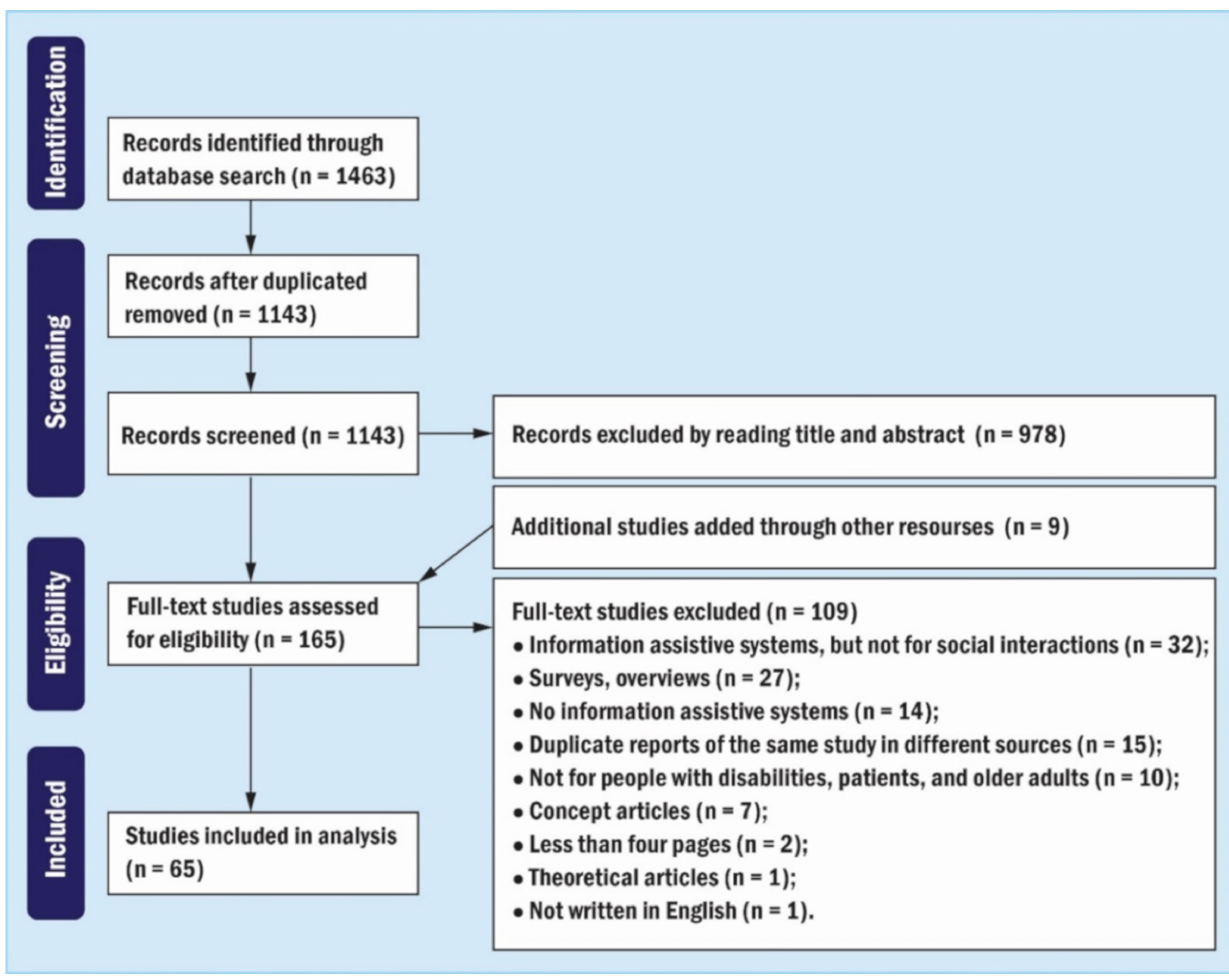
Figure 2. PRISMA flow chart of our dataset according to